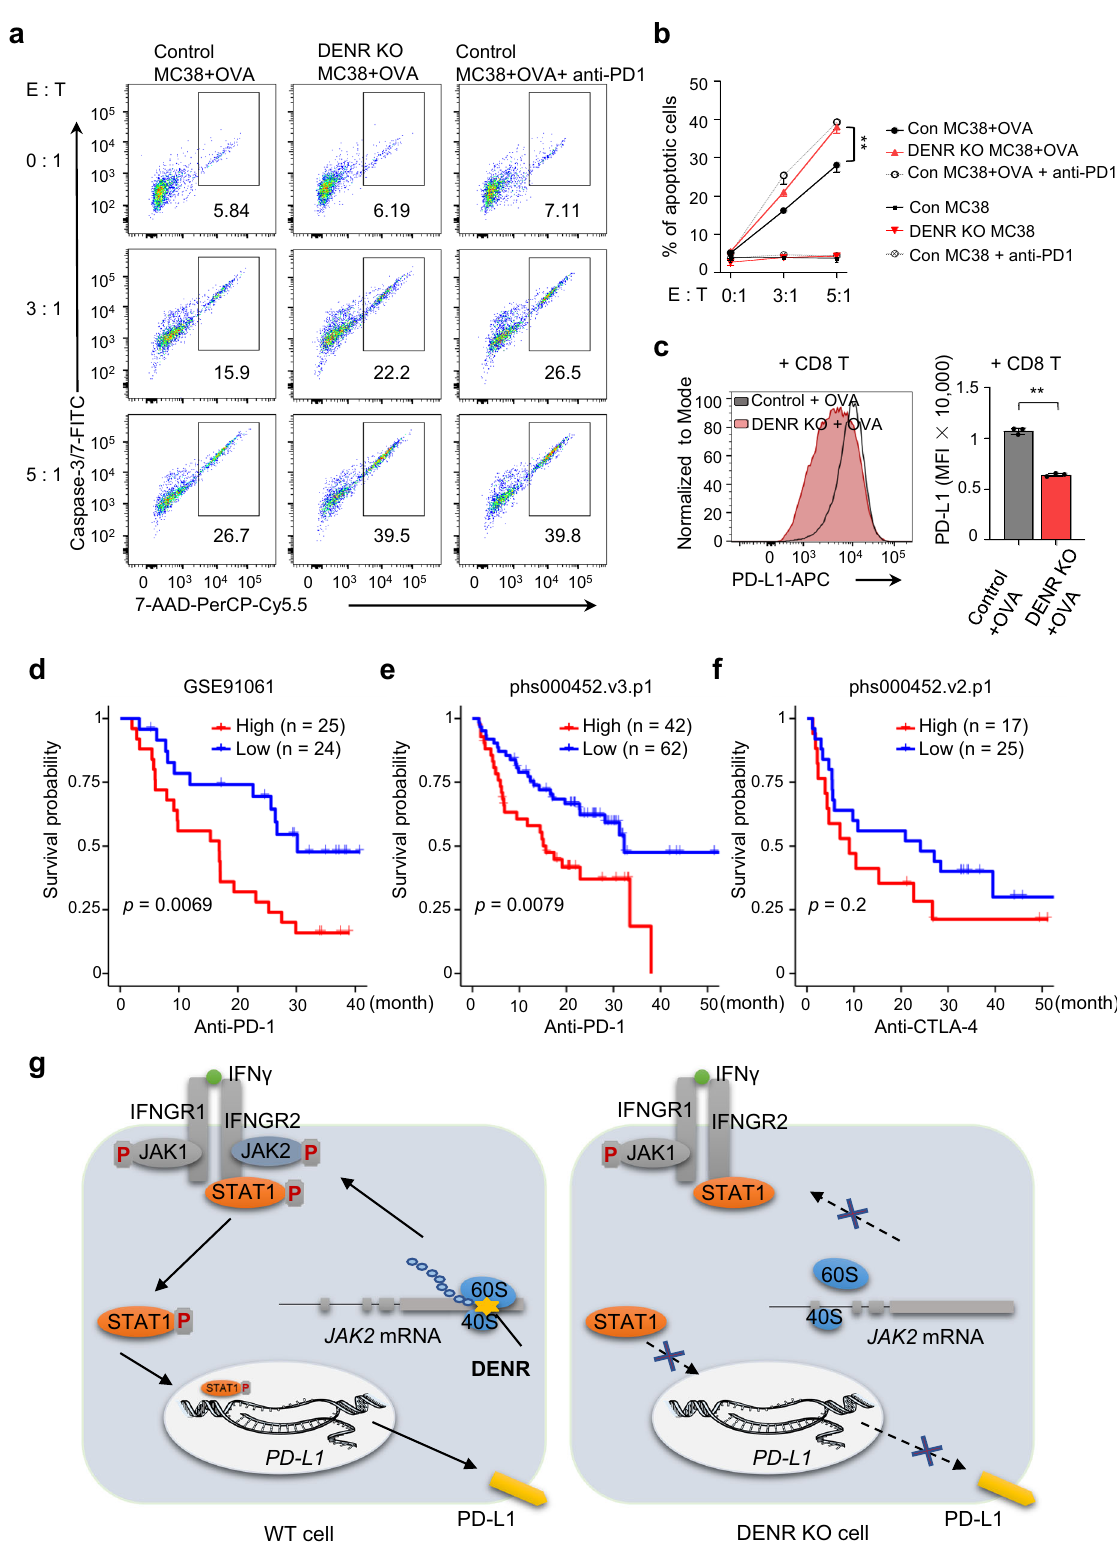
RNA extraction for RNA-seq and quantitative real-time PCR . For RNA-seq, First strand cDNA was synthesized using random hexamer primer and M-MuLV Reverse Transcriptase, then using RNase H to degrade the RNAs. Second strand MC38 control and DENR KO cells were stimulated with IFN γ (20 ng/ml) for 4 h cDNA synthesis was subsequently performed using DNA Polymerase I and dNTP. and total RNA was extracted using TRIZOL (Invitrogen #15596026). RNA pur- Remaining overhangs were converted into blunt ends via exonuclease/polymerase i fi cation, reverse transcription, library construction, and sequencing were per- activities. After adenylation of 3 ′ ends of DNA fragments, adaptor with hairpin formed by Novogene Co., Ltd. (Shanghai, China) according to the manufacturer ’ s loop structure were ligated to prepare for hybridization. In order to select cDNA instructions (Illumina). Brie fl y, mRNA was puri fi ed from total RNAs by using fragments of preferentially 370 – 420 bp in length, the library fragments were poly-T oligo-attached magnetic beads and fragmented by the fragmentation buffer. NATURE COMMUNICATIONS| (2022) 13:2059